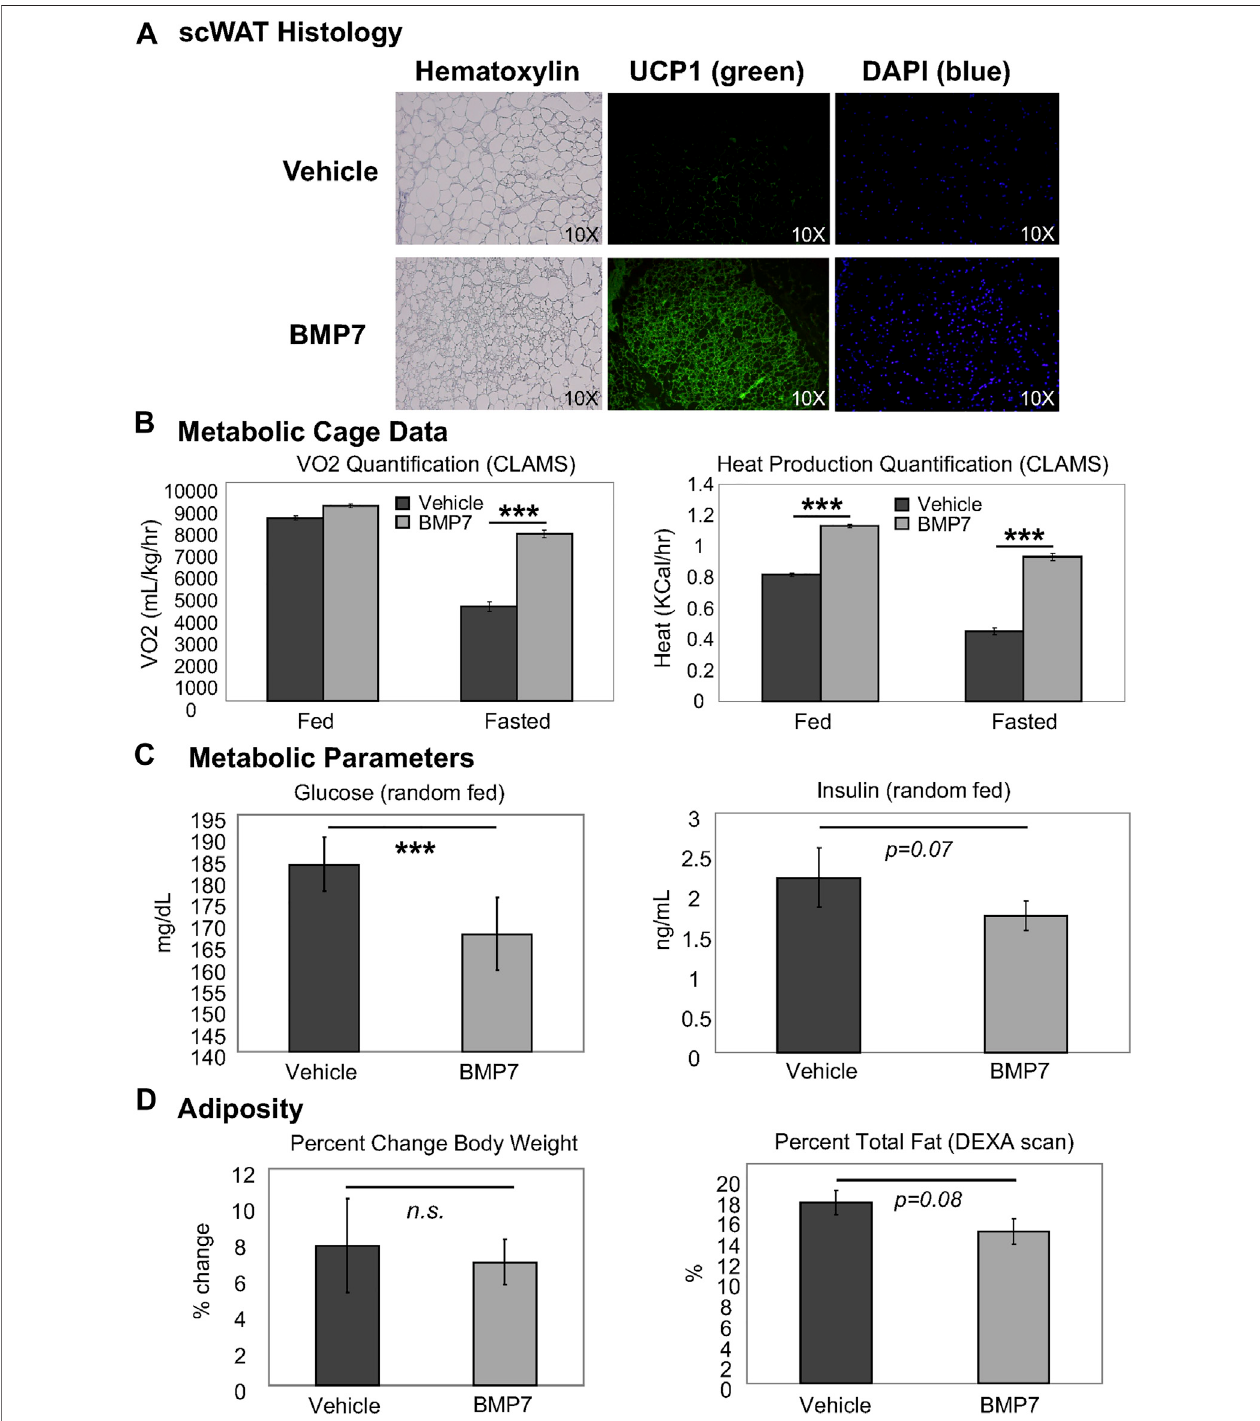
FIGURE 2 | BMP7 delivery to scWAT increases UCP1+ browning and improved metabolic parameters. (A) Mice treated with BMP7 hydrogel to the fl ank scWAT depot displayed adipose histology indiciative of ‘ browning ’ , including increased presence of multilocular cells (hematoxylin, left panels) and UCP1 positive cells (green immunostaining, middle panels). DAPI (blue, far right panels) is used to show cell nuclei. For these studies, N = 6-8 mice per group (BMP7 or empty silk hydrogel) were used. (B) CLAMS metabolic cages were used to measure whole body energy utilization in mice treated with vehicle or BMP7-loaded silk hydrogel to scWAT. A signi fi cant increase in VO2 was observed in BMP7-treated mice in the fasted state only, but heat was higher for BMP7-treated mice in both the fed and fasted state. (C) ELISAassayswereusedtomeasurecirculatingglucoseandinsulininrandom-fedanimals,andglucosewassigni fi cantlylowerinBMP7-treatedanimals(leftpanel),while insulin showed a trend to be reduced (right panel). (D) Across the study, chow-fed animals showed no difference in body weight with BMP7 treatment (left panel), but a trend for reduced total adiposity (body fat measured in a DEXA scan; right panel).